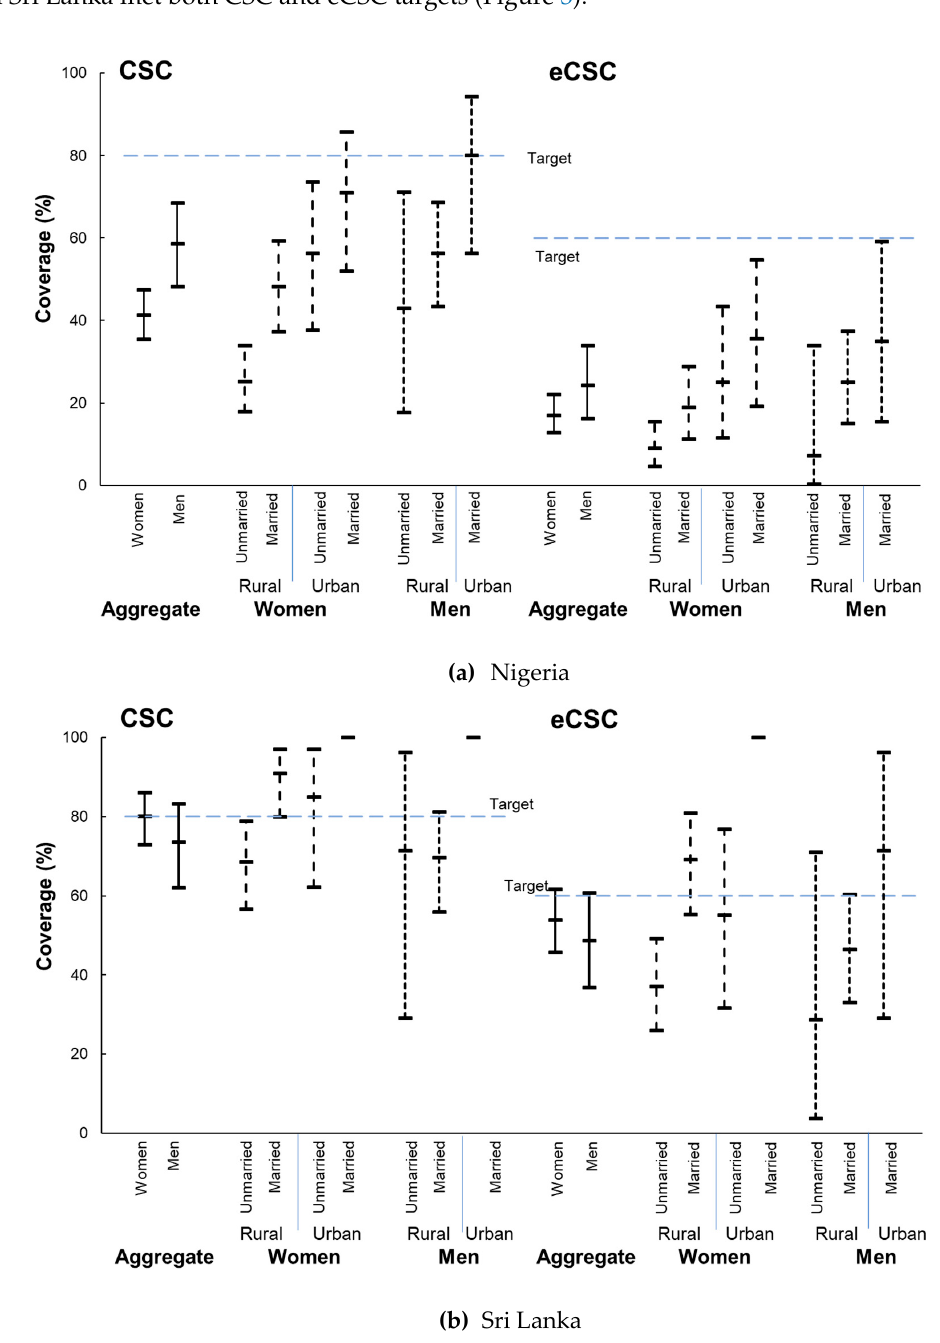
Figure 3. Cataract surgical coverage (CSC) and effective cataract surgical coverage (eCSC) across social subgroups of women and men aged ≥ 40 years in ( a ) Nigeria (2005–2007) and ( b ) Sri Lanka (2012–2014). CSC, eCSC, and their 95% CI are shown by the vertical bar for each subgroup. CSC target 80% [20], eCSC target 60% [21]. The CSC value in married urban women and men and urban not-married men in Sri Lanka was 100%, as was eCSC in urban not-married men. In Nigeria, zero not-married urban men had surgery.